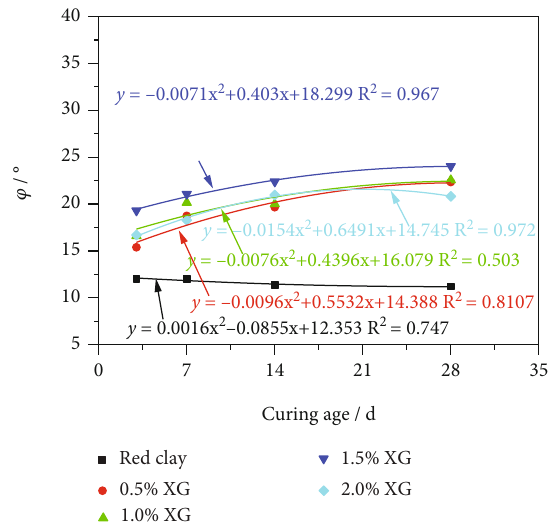
Figure 15: Relationship between curing ages and internal friction